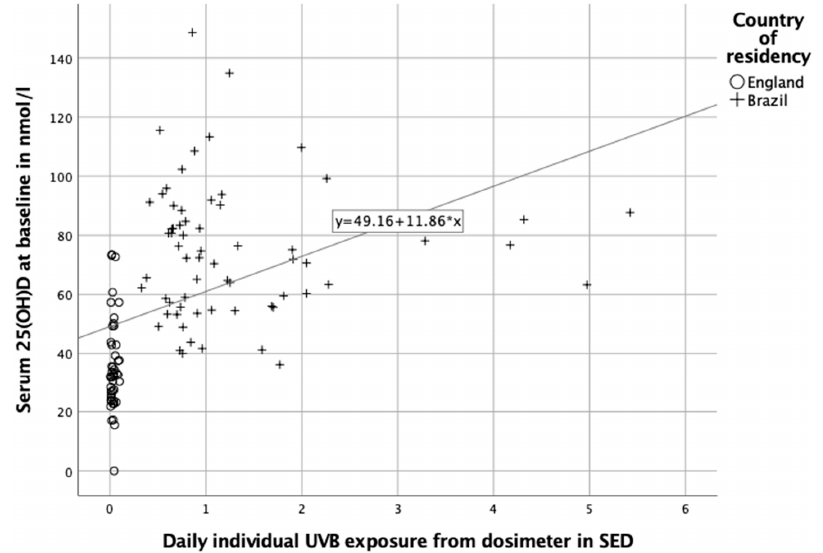
Figure 4. Relationship between baseline serum 25(OH)D concentration and baseline individual daily sunlight exposure level in participants with daily individual UVB exposure levels below 10 SED ( n = 112).